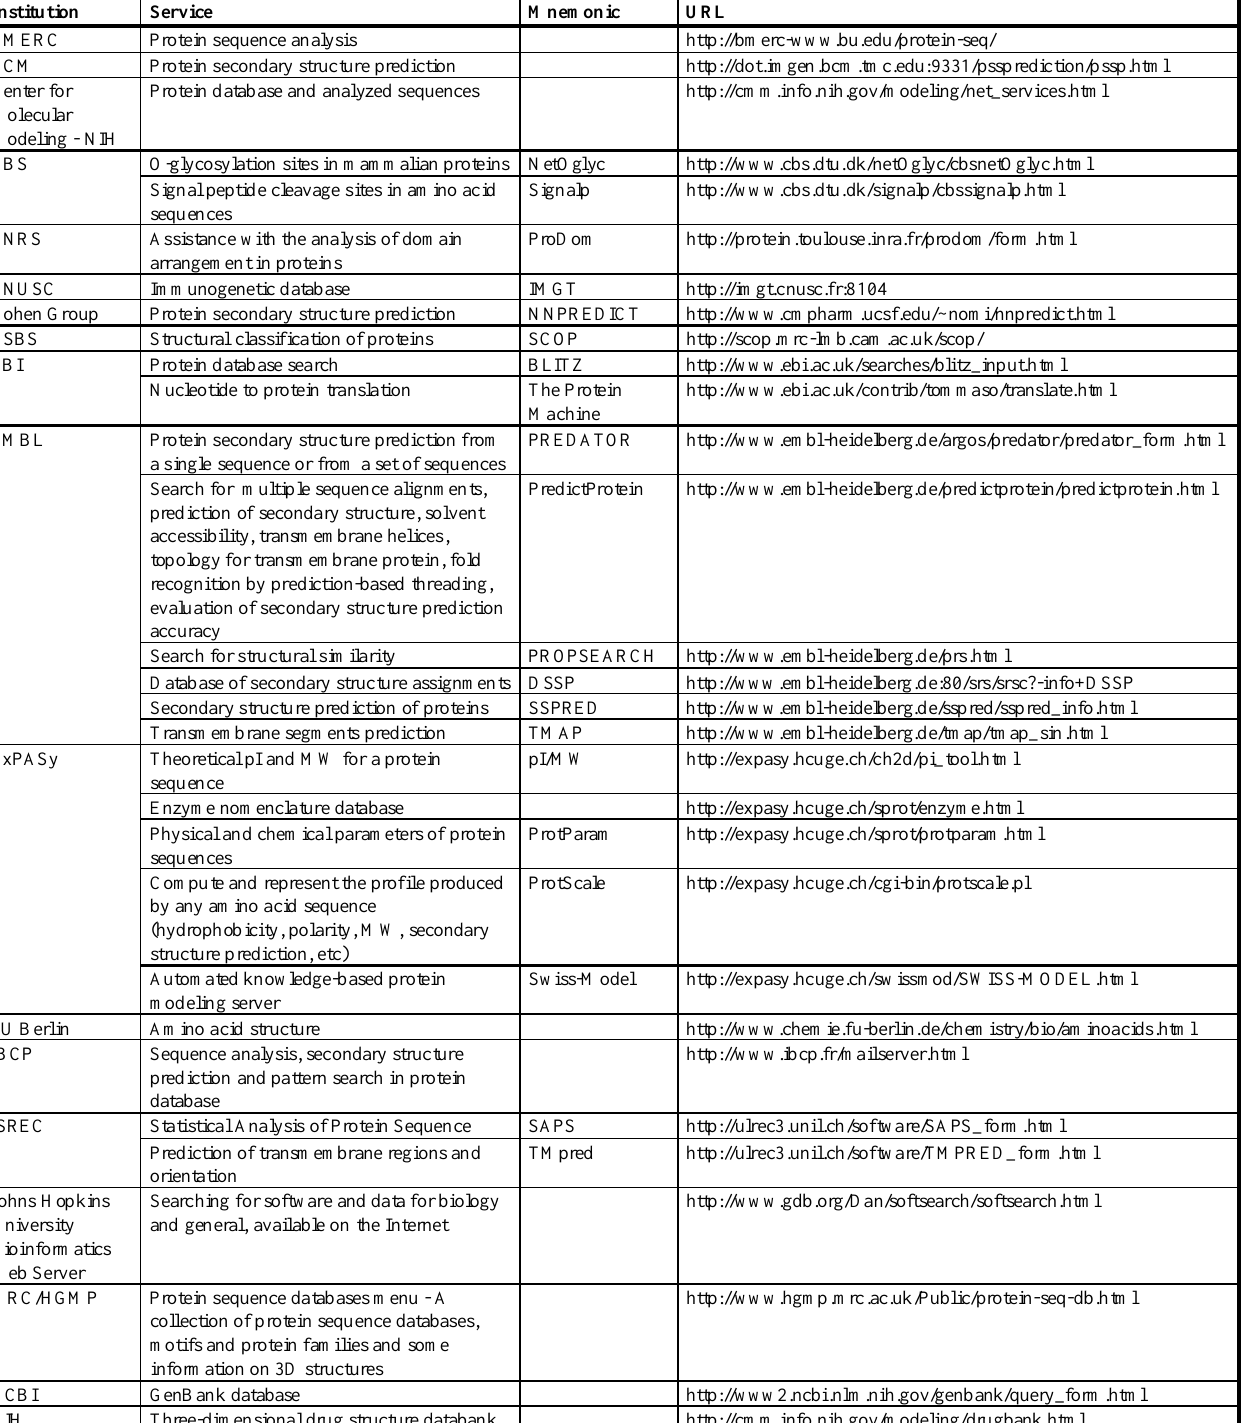
Table 2 - Analysis and search